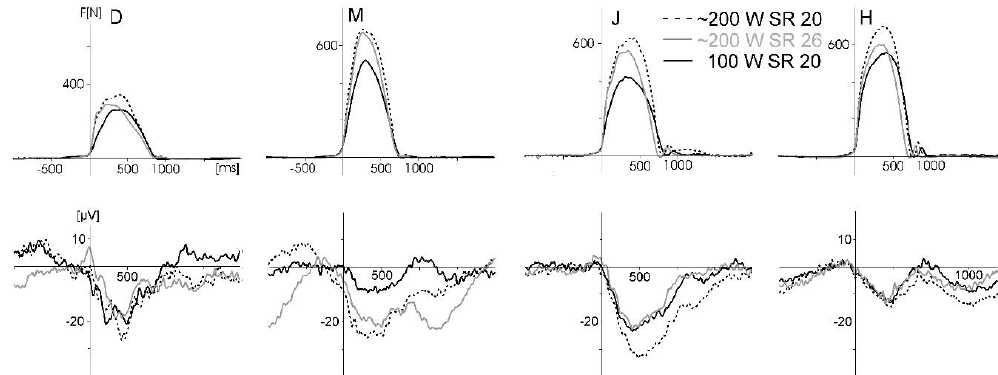
Figure 6. Force graphs (top row) and electrical activity (below) for the three di ff erent rowing conditions for all four subjects (D, M, J, and H) of pilot Study 3. Black solid: power 100 W, 20 strokes / min. Black dotted: 180–200 W, 20 strokes / min. Gray: 180–200 W, 26 strokes / min (lower power values for D). The electrical activity reflects the motor-related ERP (triggered by force onset, baseline − 500 ms to 0) plus movement-related artefacts. Six bilateral sites (FC1, C3, CP1, FC2, C4, and CP2, referenced to the right mastoid) were averaged for this figure. The number of rowing cycles included in the di ff erent averages were between 54 and 88. Only a few EEG segments showing excessive and clearly identifiable artefacts (e.g., voltage jumps) were excluded.